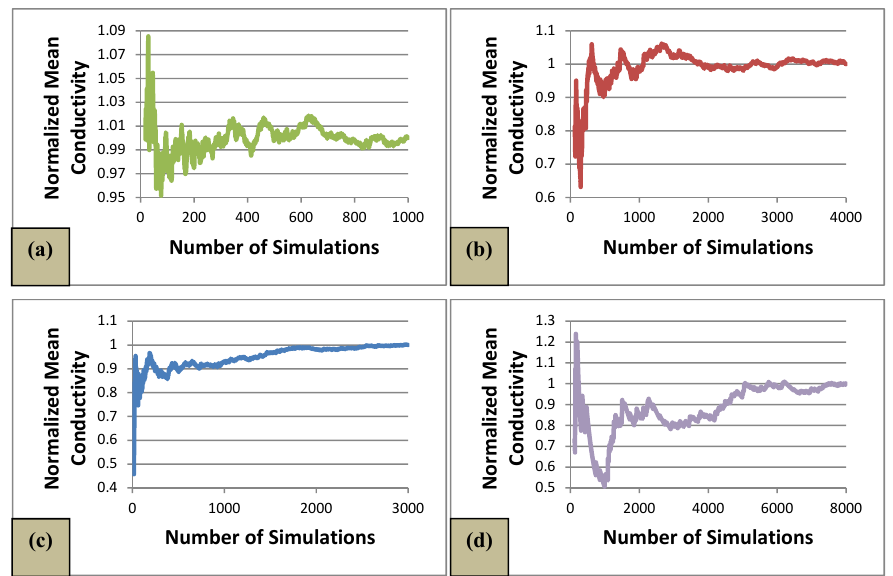
Figure 28. Normalized mean conductivity ( a ) c = 0.05; ( b ) c = 0.04; ( c ) c = 0.03; and ( d ) c = 0.02. The conductivities were also compared to experimental values [30]. In their work, Potschke et al. measured the resistivity of PNCs with MWCNTs with diameters between 10 and 15 nm and length between 1 and 10 µm in a polycarbonate (PC) matrix. It can be seen in Figure 29 that the experimental data obtained from Potschke et al. is in closer agreement with the values obtained in this work than those from the simulation by [12]. The discrepancy in the values ranging from 0.01 and 0.03 volume fractions between our work and those obtained experimentally by [30] can be attributed to a difference in the exact location of the percolation threshold. For the work in [30], a sudden drop in conductivity occurs below 0.04 volume fraction, while our work shows a steady decrease until 0.02 volume fraction. Ultimately, this discrepancy could also be attributed to the difference in polymer matrix.